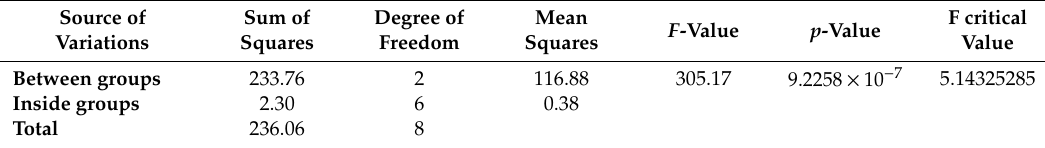
Table 5. Analysis of variance for the drying